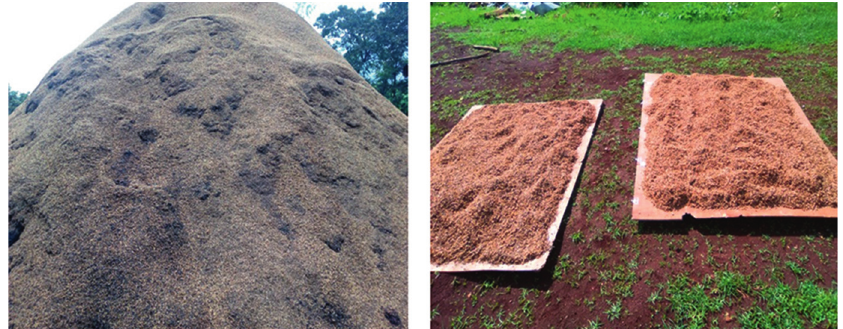
Figure 3: Coffee husk collected from industries.